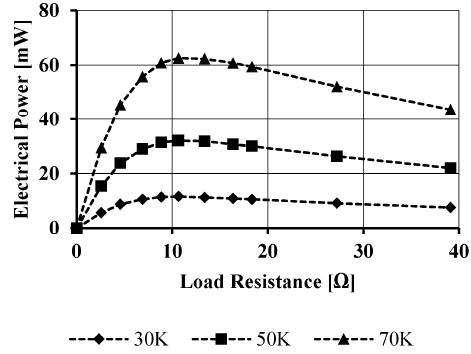
Figure 7. Load-dependent generated electrical power of a small bulk-TEG at different temperature gradients; temperature level was at 0 °C.